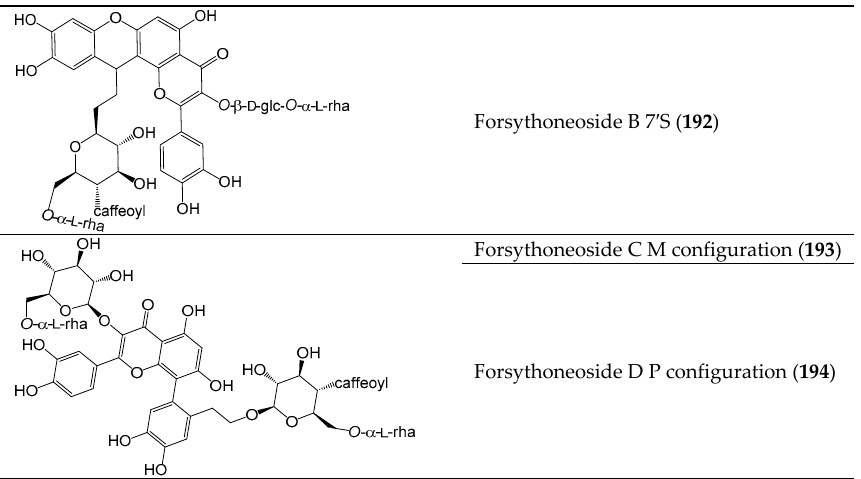
Figure 6. Chemical structures of flavonoids in Forsythiae Fructus.